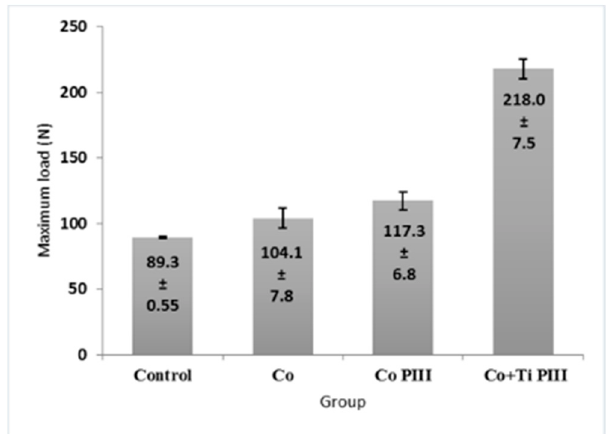
Figure 8. Maximum load of mechanical resistance of the surgical area in the studied groups. G1 (Control), G2 (Co), G3 (Co PIII), G4 (Co+Ti PIII).